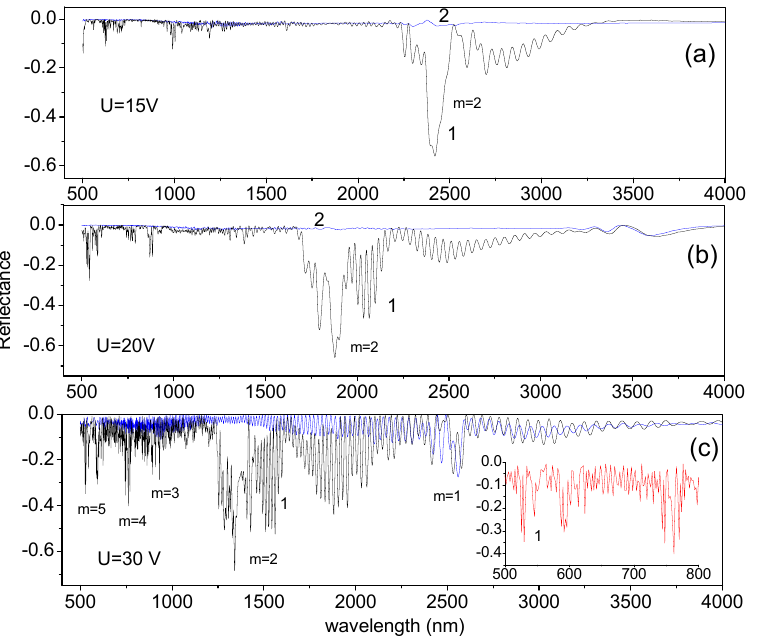
Figure 11. ( a – c ) Reflectance spectra for the z- (1) and y -polarized (2) components of the light at different voltages U . The inset in ( c ) shows a fraction of the same spectrum in visible range with a higher spectral resolution.